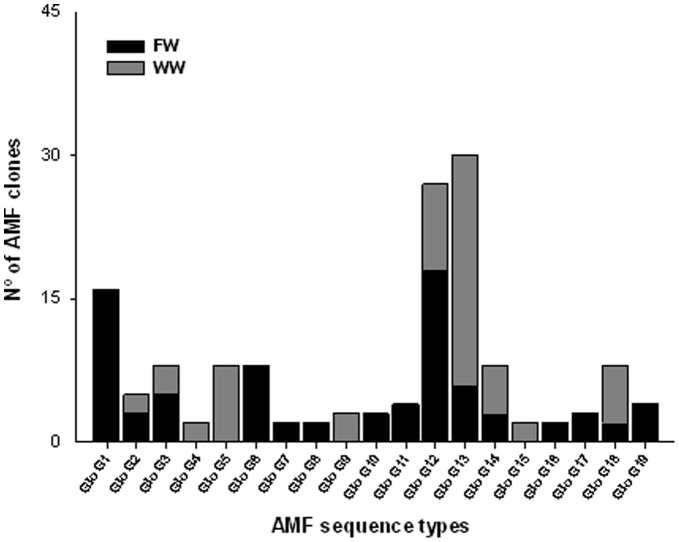
Bar plot showing the number of clones detected for each AM fungal sequence type in the soil irrigated with fresh water (FW) and treated wastewater (WW) 43 years after establishment.